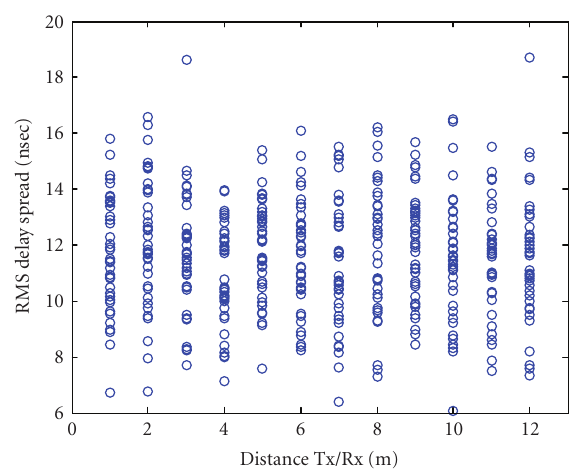
Figure 12: RMS delay spread versus mean excess delay, all channels, LOS (15dB threshold).